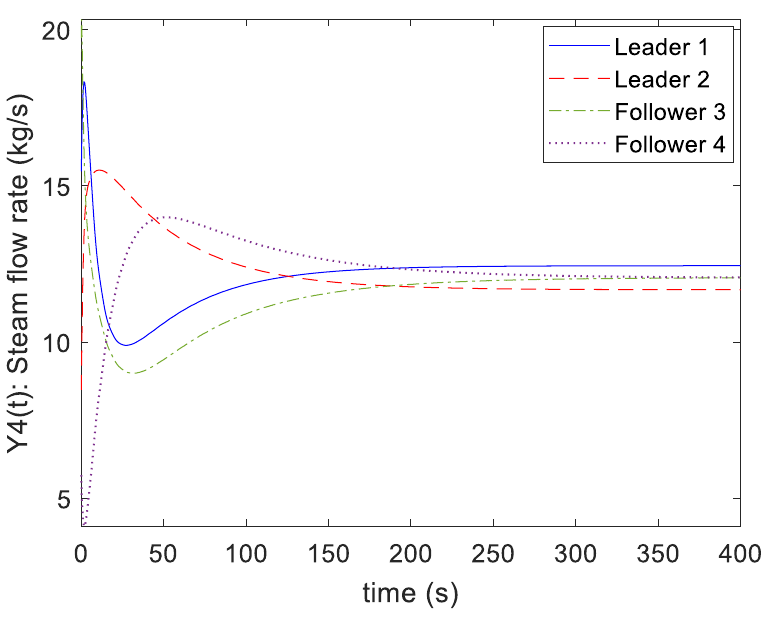
  Y t with IT-2 fuzzy control. 4